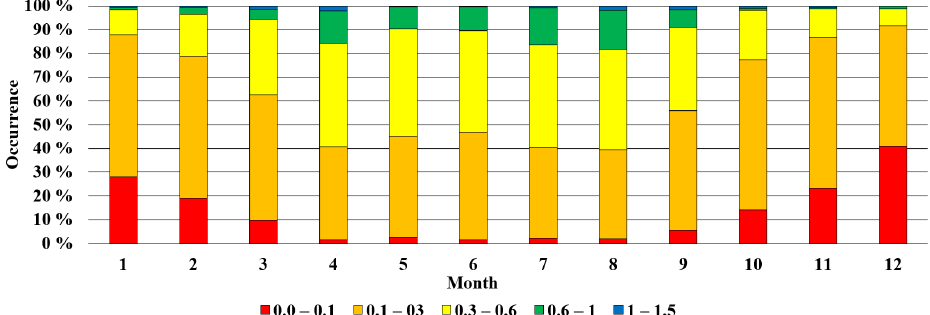
Figure 14. Relative contribution of daily average values of AOD to the monthly averages for the wavelength of 320nm,